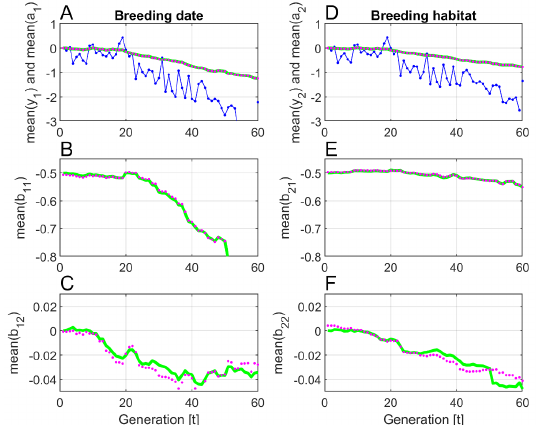
Figure 4: Typical responses for Case 1 in Table 1. True y and y values are shown by solid 1 ,t 2 ,t and (cid:98) y are blue lines, while predictions (cid:98) y 1 ,t 2 ,t shown by blue dots. True mean trait re- sponses are shown by green lines, while pre- dictions are shown by magenta dots.